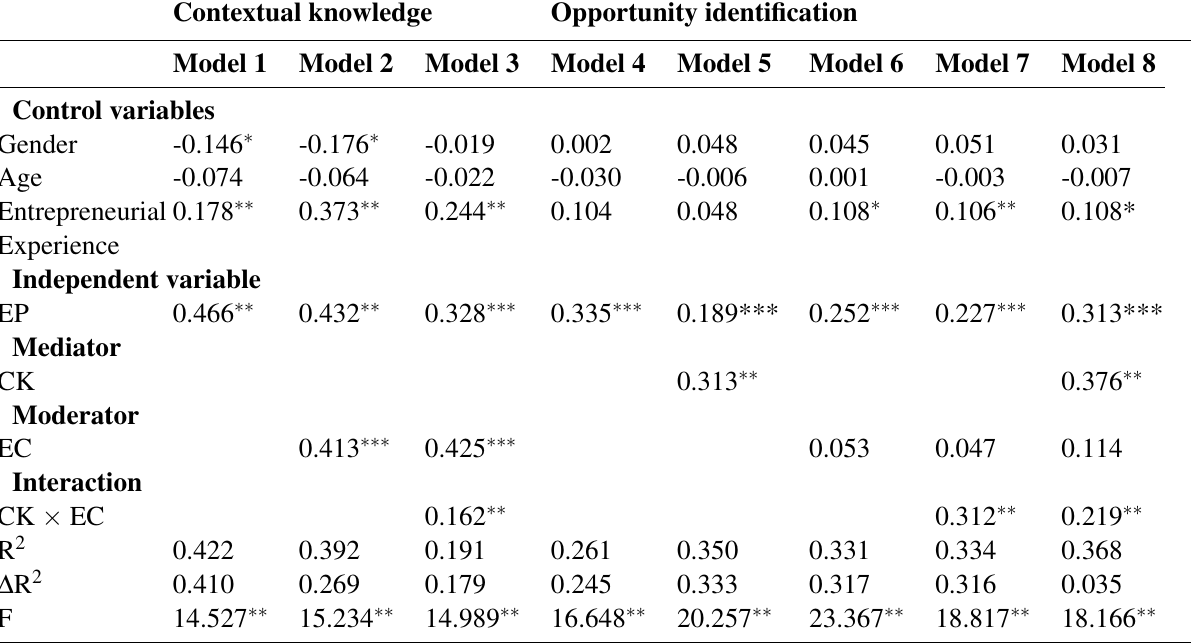
Table 4 Results of multiple regression